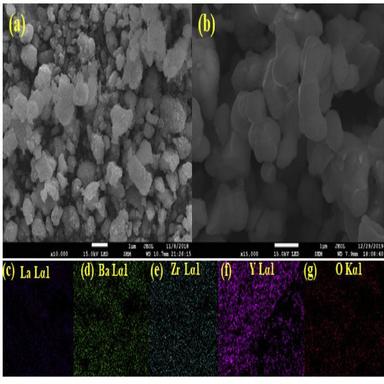
(a) SEM view of BZY and (b) La-doped BZY powder while (ceg) shows the EDS images of La, Ba, Zr, Y, and O, respectively.